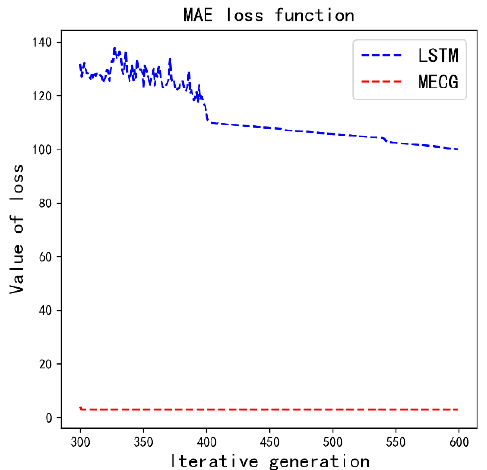
Figure 19. Convergence rate of LSTM and MECG models after 300 iterations.